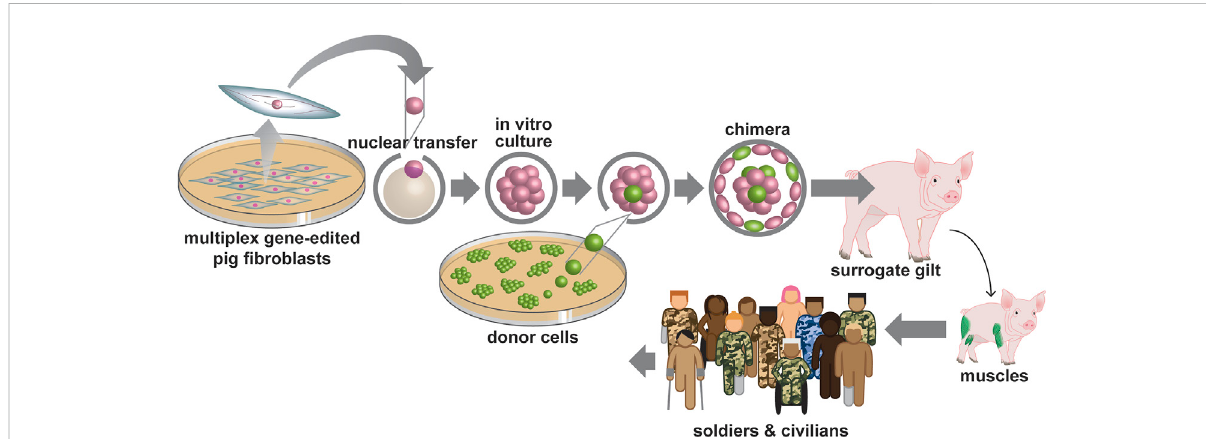
Gene editing, Somatic cell nuclear transfer (SCNT) and blastocyst complementation strategies to produce humanized skeletal muscle. CRISPR based multiplex gene editing is used to delete the porcine skeletal muscle lineage from porcine fi broblasts. Somatic cell nuclear transfer is used to clone the lineage de fi cient porcine fi broblasts and produce porcine embryos that cannot produce skeletal muscle. Blastocyst complementation is used to rescue the skeletal muscle null phenotype by delivering human cells, to the porcine embryo, capable of producing human skeletal